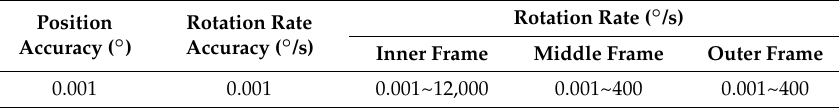
Table 2. Technical parameters of tri-axial flight simulator.